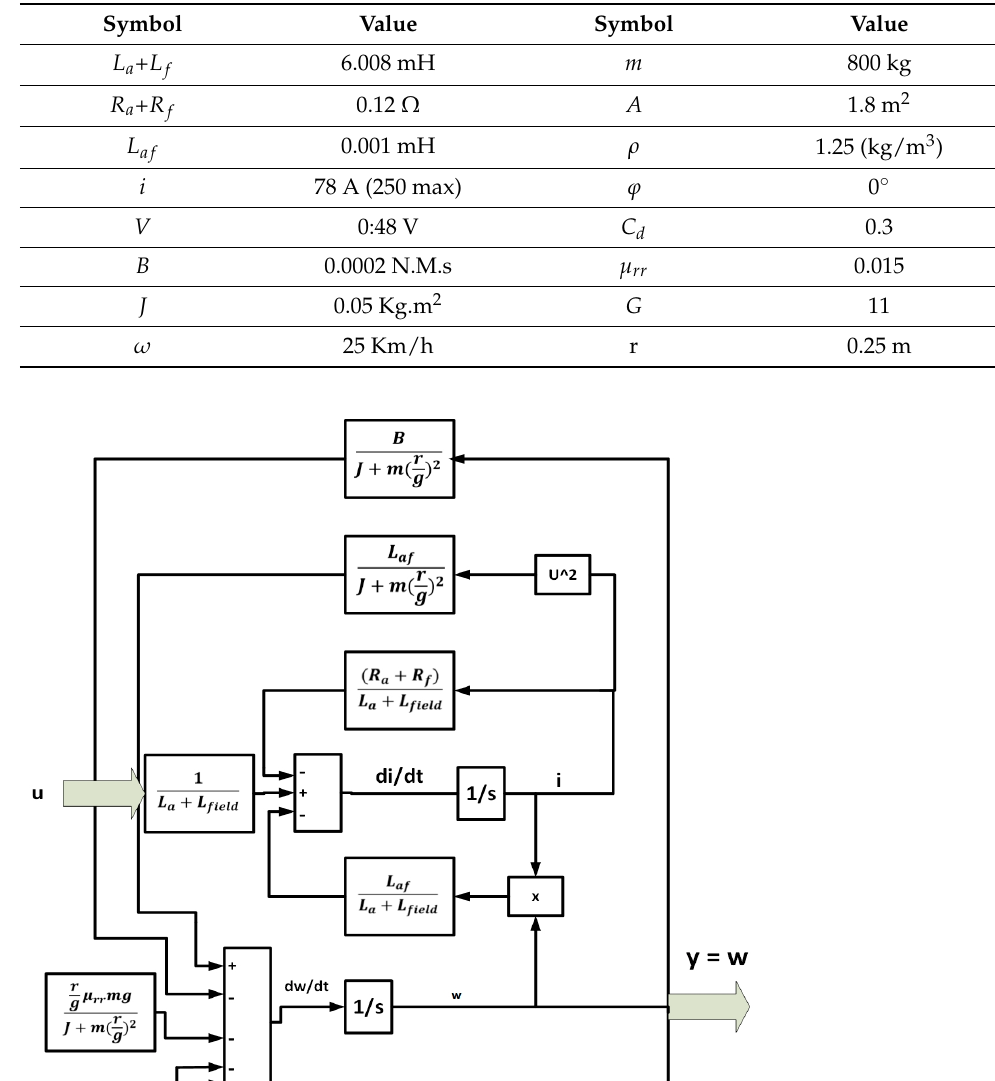
Table 1. Parameters of a nonlinear EV system.